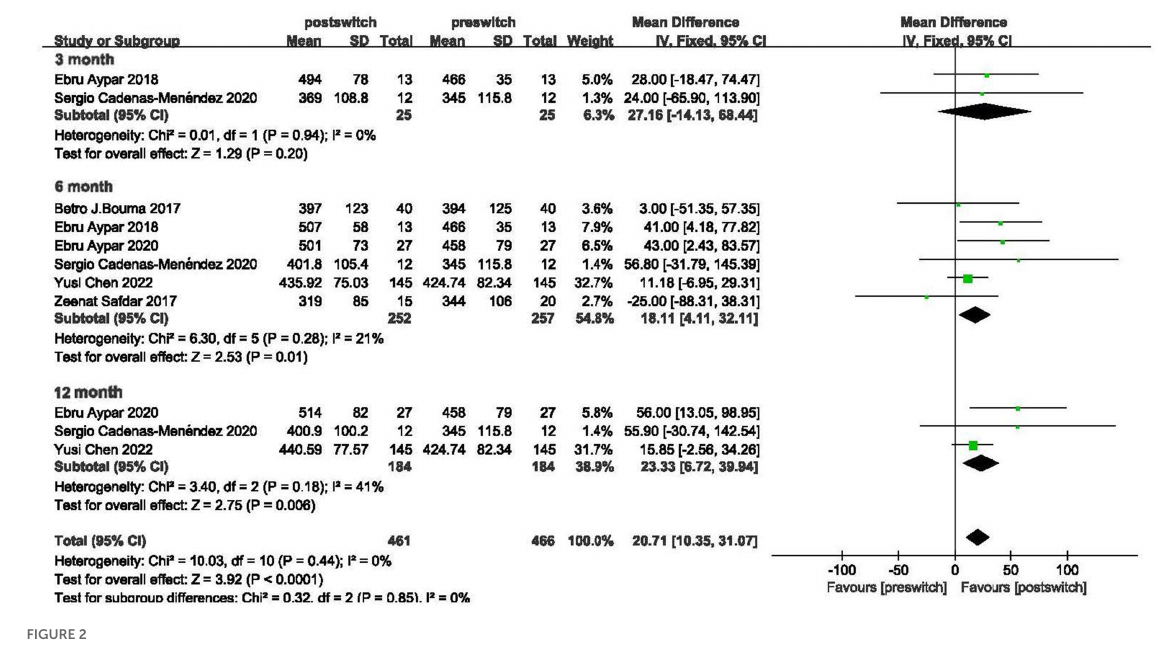
FIGURE2 Changes in the 6-min walk distance after transition.